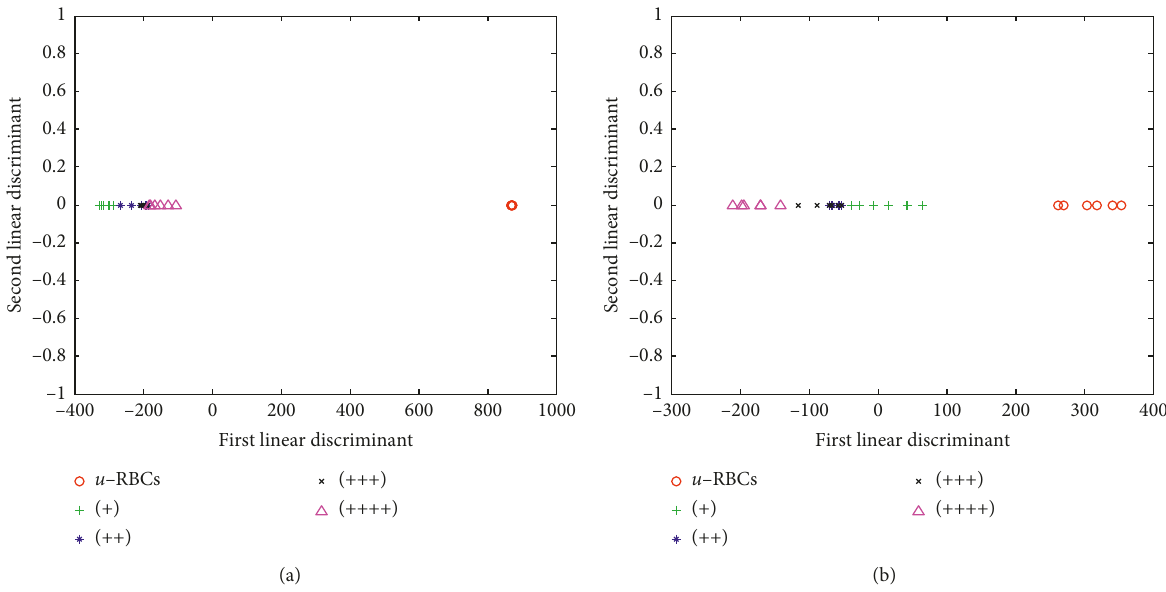
Figure 9: Scatter plots of first and second Fisher’s linear discriminants showing transmitted pixel intensities of uninfected red blood cells ( u - RBCs) and Plasmodium falciparum -infected human red blood cells i -RBCs (+) with parasite density: (+), (++), (+++), and (++++) for (a) 435nm and (b) 660nm illumination light